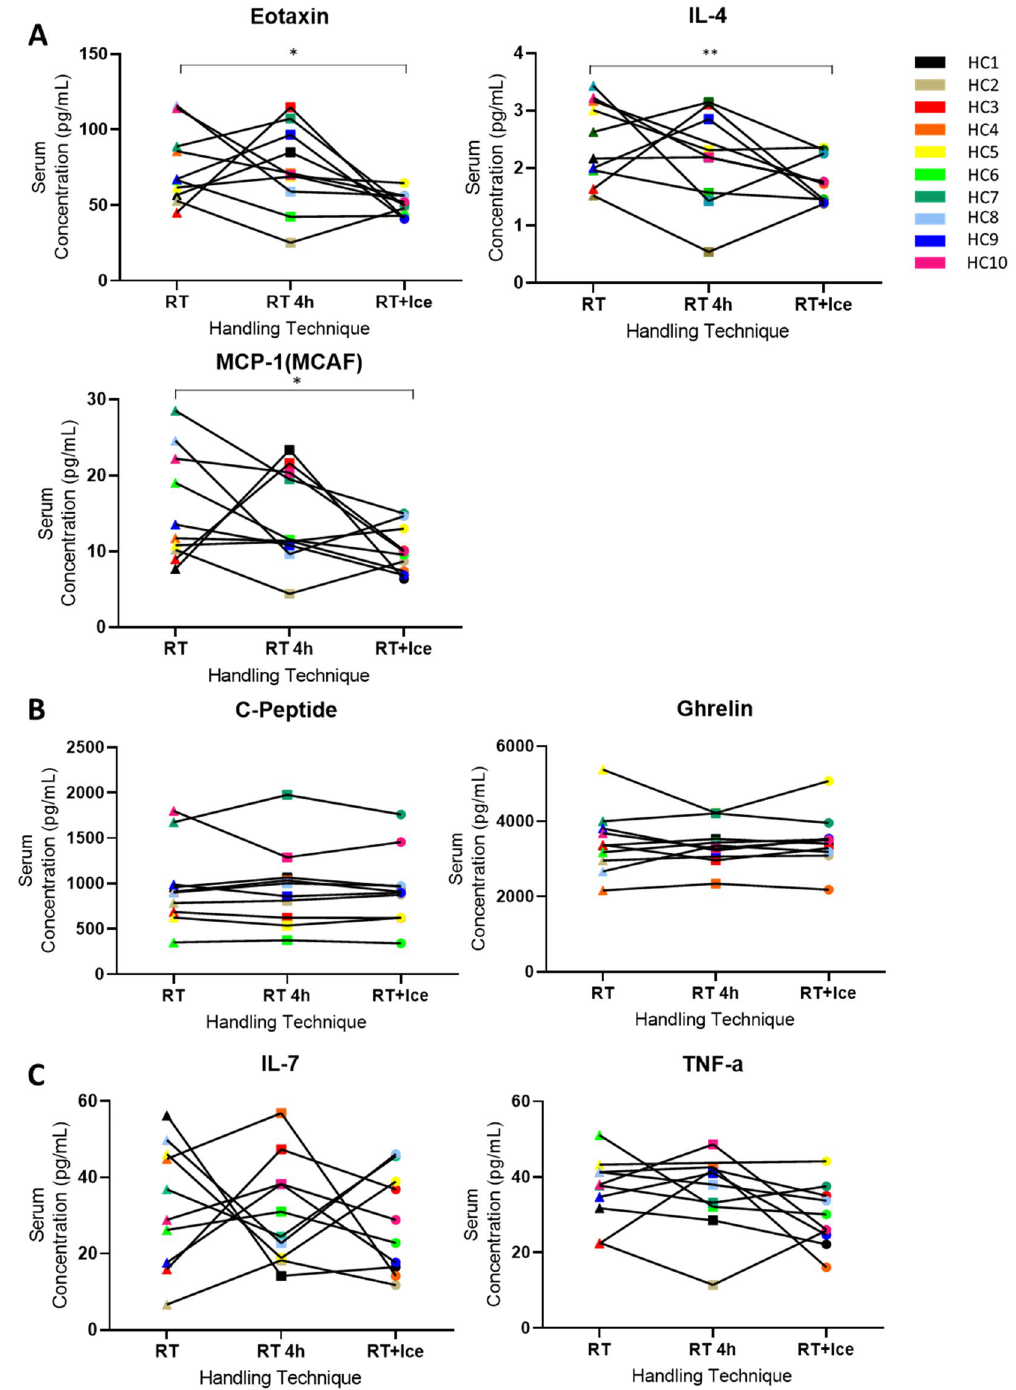
Figure 3. The effects of a delay and pre-processing protocols on serum analyte levels. The serum levels of selected analytes in healthy control samples following three pre-processing protocols are shown. The reference protocol 1 h at room temperature (RT) and two delay protocols, 1 h at room temperature followed by a further 3 h on ice (RT + Ice) or 1 h at RT followed by a further 3 h at RT (RT 4 h) were compared. ( A ) Significant differences were identified in eotaxin, IL-4 and MCP-1 levels. ( B ) Some analytes demonstrated minimal changes. ( C ) While no statistical difference are observed for some analytes, specific individual samples undergo considerable changes in response to handling variables. Paired t-tests were performed to examine for significant differences between mean analyte levels in samples from reference and alternative protocols. * represents p ≤ 0.05, ** represents p <